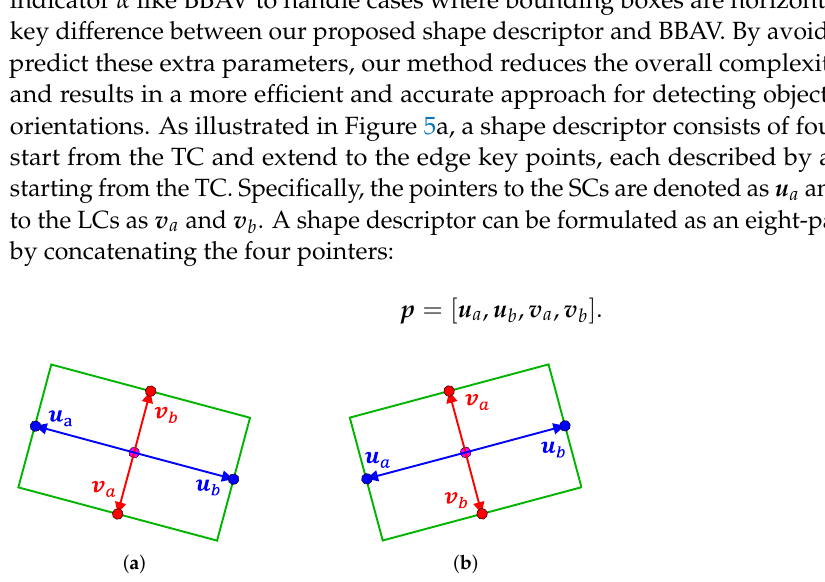
Figure 5. Definition of shape descriptor and illustration of the boundary problem caused by fixed edge point assignment rule. The green box denotes a ground truth box. The blue and red arrows represent the pointers to the SCs and LCs,